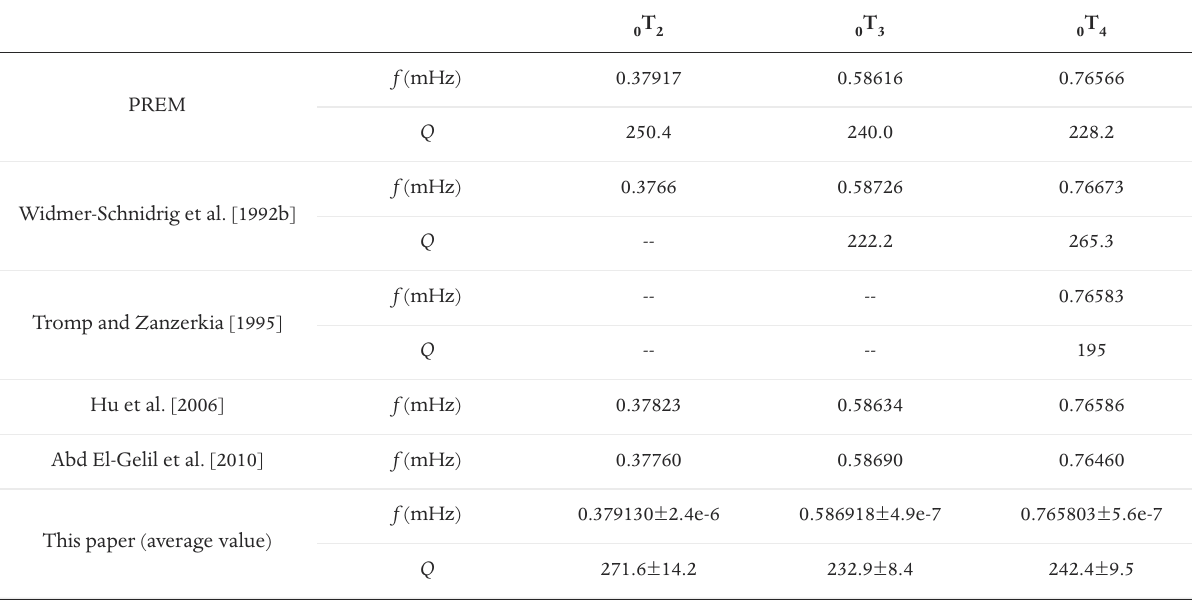
T , T , and T , compared to the PREM predictions and the re- 0 2 0 3 0 4